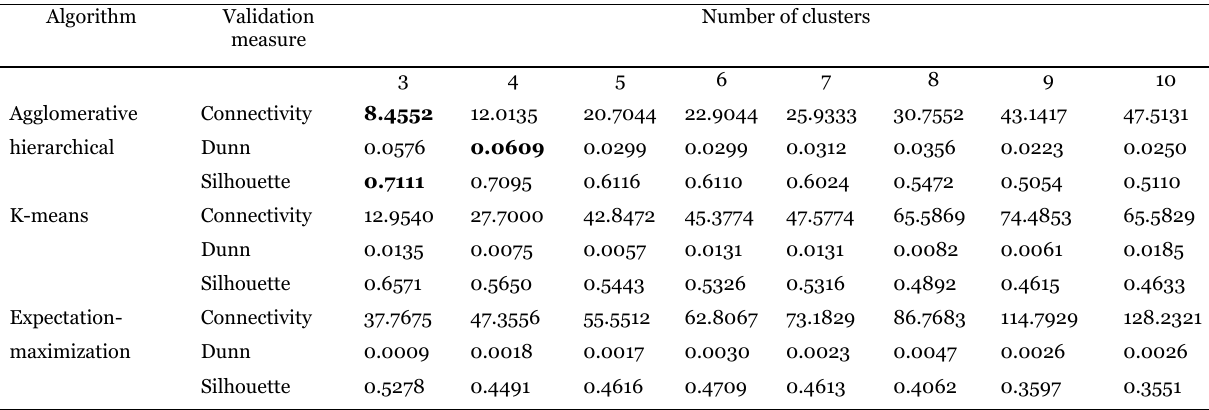
Optimal Algorithm and Cluster Evaluation